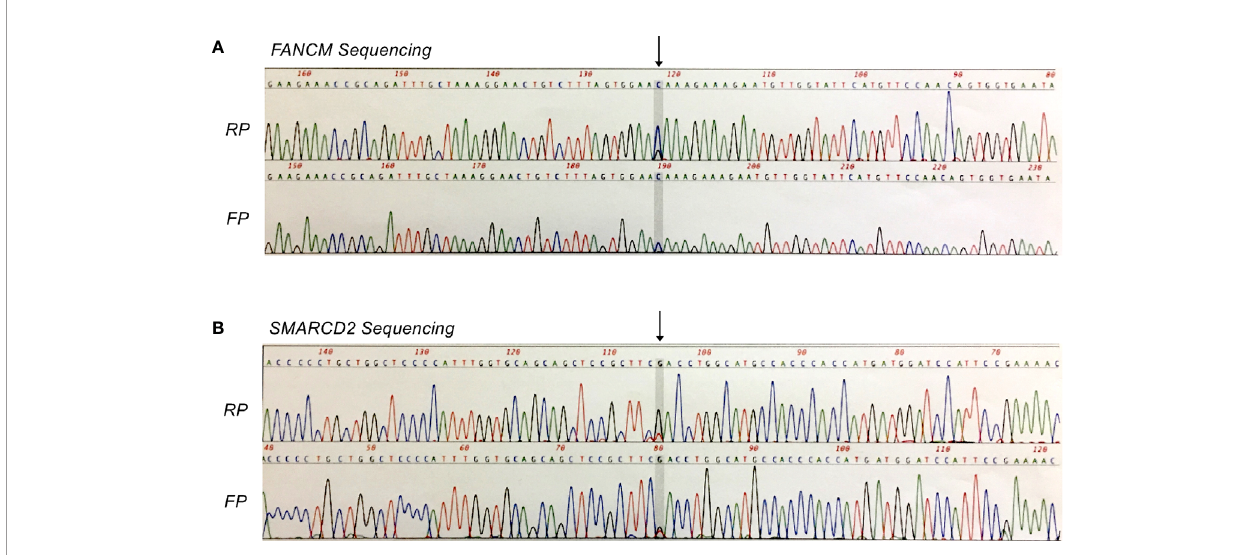
FIGURE 3 | Sanger con fi rmation of missense mutations identi fi ed by whole exome sequencing analysis. (A) Heterozygous FANCM mutation (c.5857C>G, p.Gln1953Glu). (B) Heterozygous SMARCD2 mutation (c.311G>T, p.Arg104Leu). FP, forward primer; RP, reverse